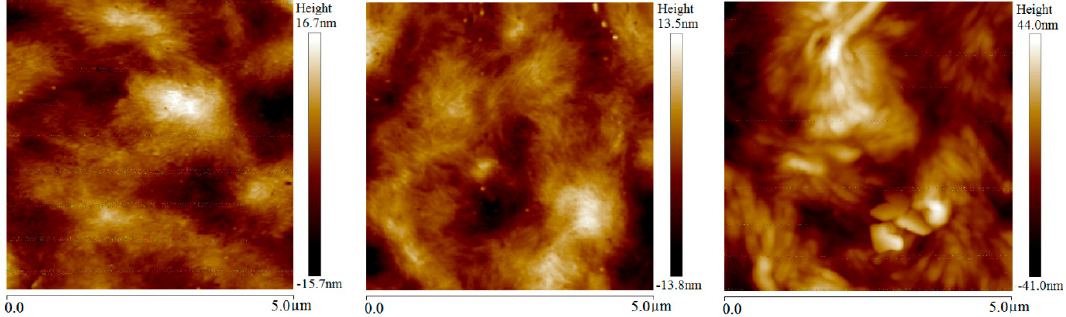
Figure 5. AFM images of 2 wt % nano-BiFeO 3 / LDPE composites without magnetization (left panel) and magnetized at room (middle panel) and elevated (right panel) temperatures.